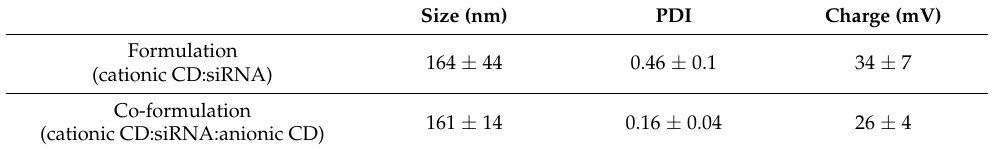
Table 1. Summary of physicochemical characterisation of CD:siRNA NPs.